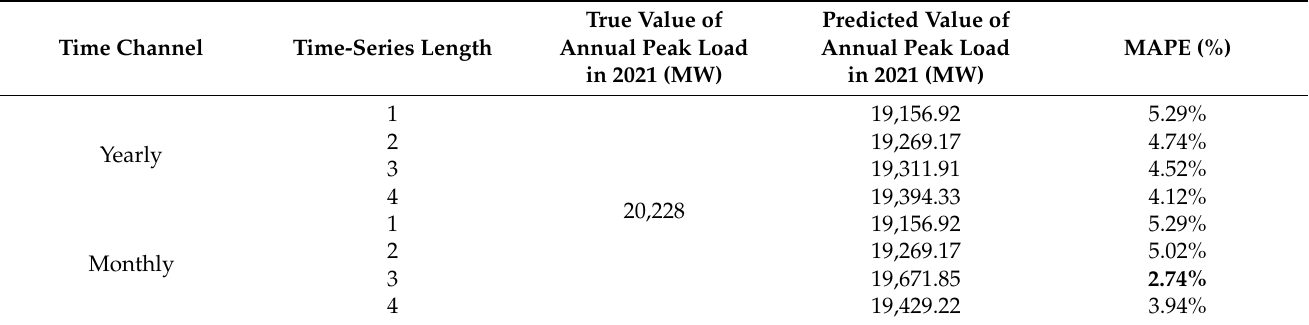
Table 4. Predictive performance of the proposed model with various time-series